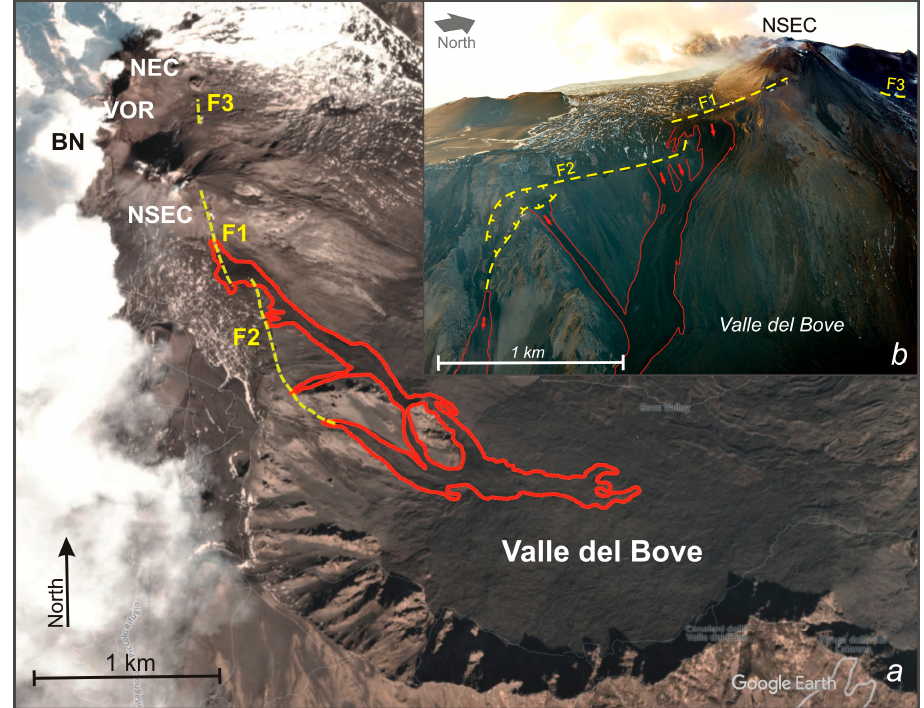
Figure 3. ( a ) Map of the 24–27 December 2018 lava flow (red outline) on a Google Earth image. The yellow dashed lines F1-F2-F3 indicate the eruptive fissures. NSEC = New South-East Crater; VOR = Voragine; BN = Bocca Nuova; NEC = North-East Crater. ( b ) Aerial view from east of the eruptive fissures (F1–3, yellow dashed lines) and main lava flow emissions (red arrows). The lower part of the F2 fissure between 2500 and 2400 m a.s.l. (on the left) formed a graben 30–40 meters wide. At higher altitudes, the graben was buried under the erupted pyroclastic products.